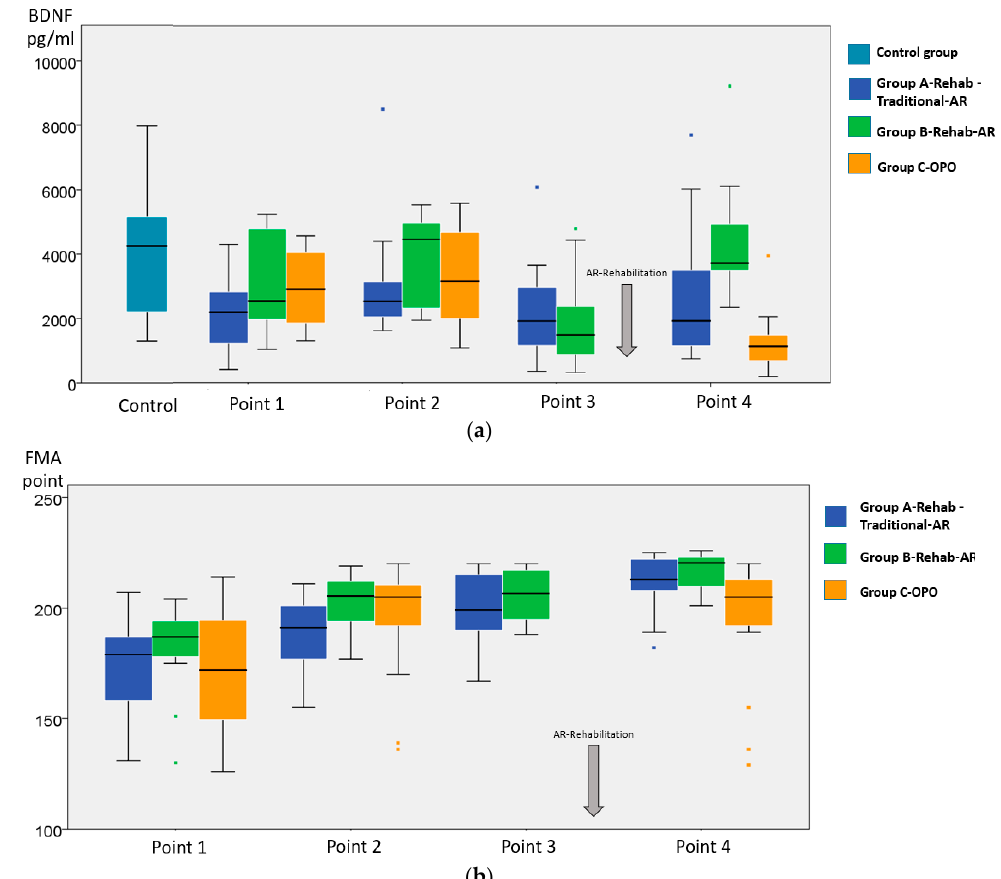
Figure 1. Serum brain-derived neurotrophic factor (BDNF) levels and Fugl–Meyer scale (FMA) scores at di ff erent points of observation. ( a ) Serum BDNF. Comparisons of groups between observation